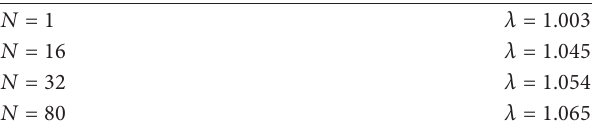
Table 1: The value of 𝜆 corresponding to different 𝑁